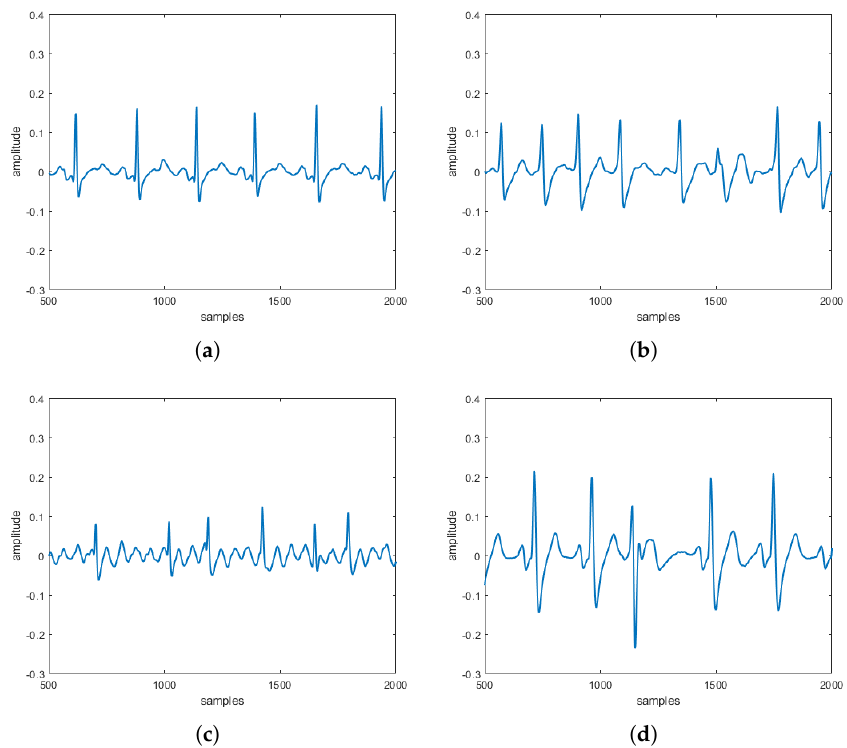
Figure 10. Case (c) of the proposed methodology: ( a ) normal sinus rhythm ( b ) atrial fibrillation ( c ) atrial flutter ( d ) premature ventricle